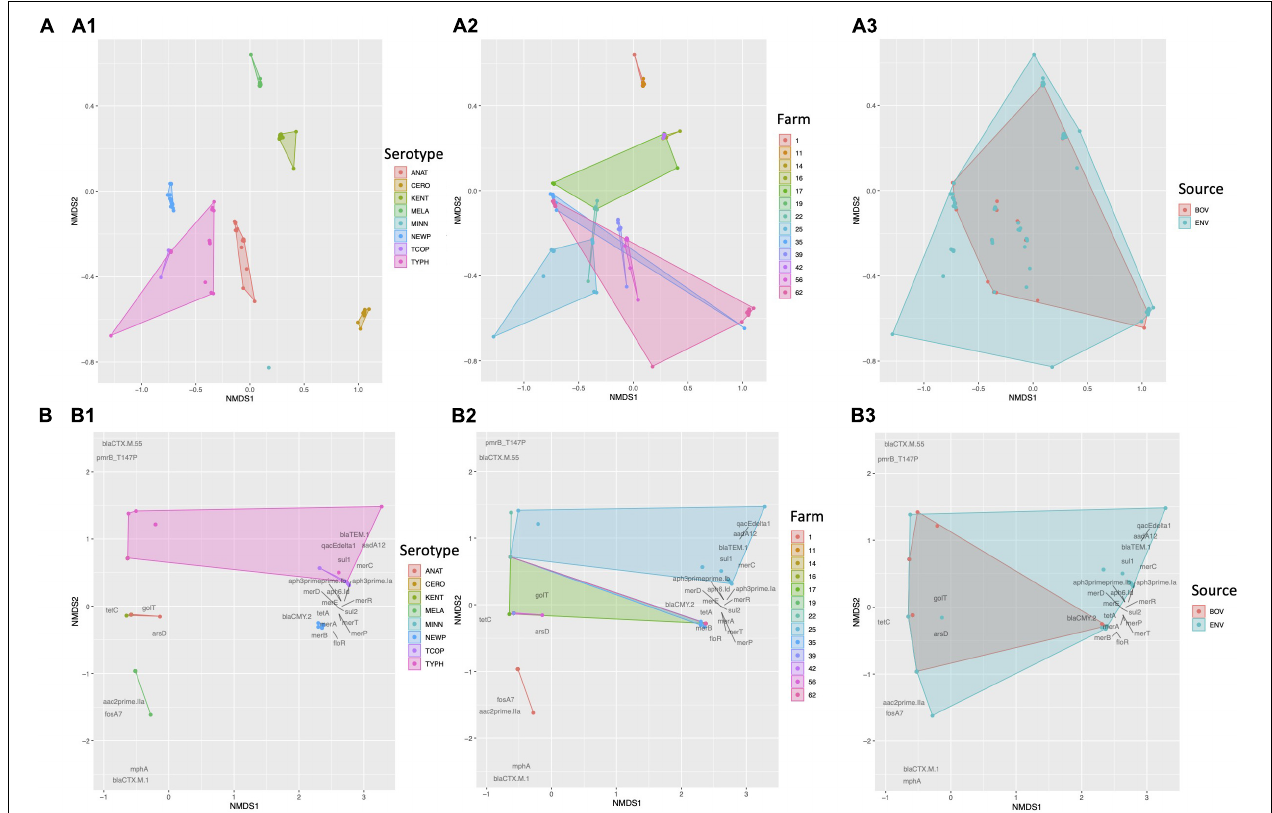
FIGURE 4 | Results of non-metric multidimensional scaling (NMDS) performed using the presence and absence of (A) pan-genome elements ( n = 4,102; identified using Roary), and (B) antimicrobial resistance (AMR) and stress response genes ( n = 28; detected using AMRFinderPlus) among 128 bovine-associated Salmonella isolates, plotted in two dimensions. Points represent isolates, while shaded regions and convex hulls correspond to isolate (1) serotypes (ANAT, Anatum; CERO, Cerro; KENT, Kentucky; MELA, Meleagridis; NEWP, Newport; TCOP, Typhimurium Copenhagen; TYPH, Typhimurium), (2) farm, and (3) source (BOV, bovine; ENV, bovine farm environment). For all plots, a Jaccard distance metric was used. For AMR/stress response genes (B) , gene names/scores are plotted in dark gray text.